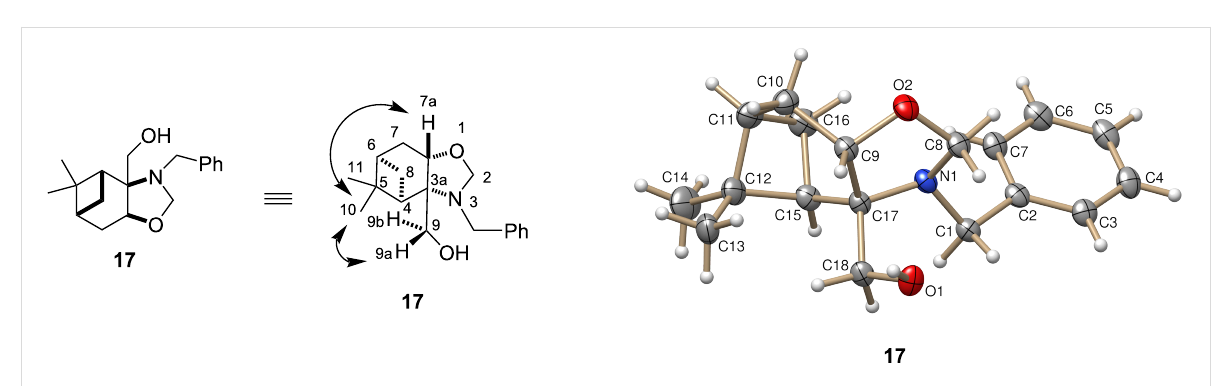
Figure 3: NOESY experiments and X-ray structure proofment of the structure of oxazolidine 17